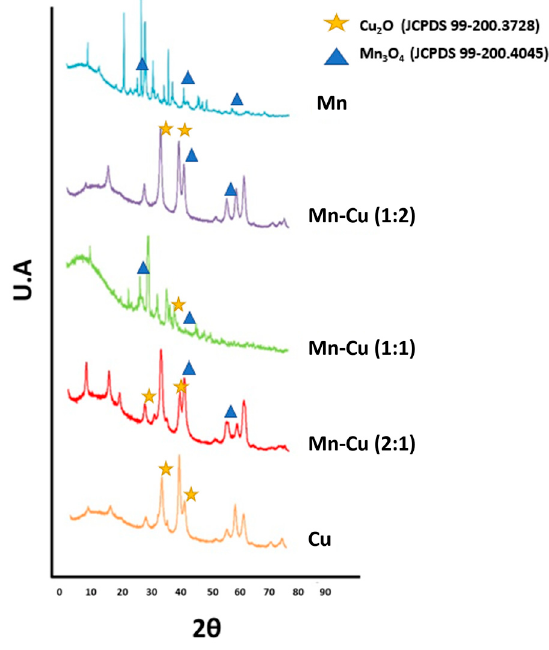
Figure 1. XRD patterns of catalyst.